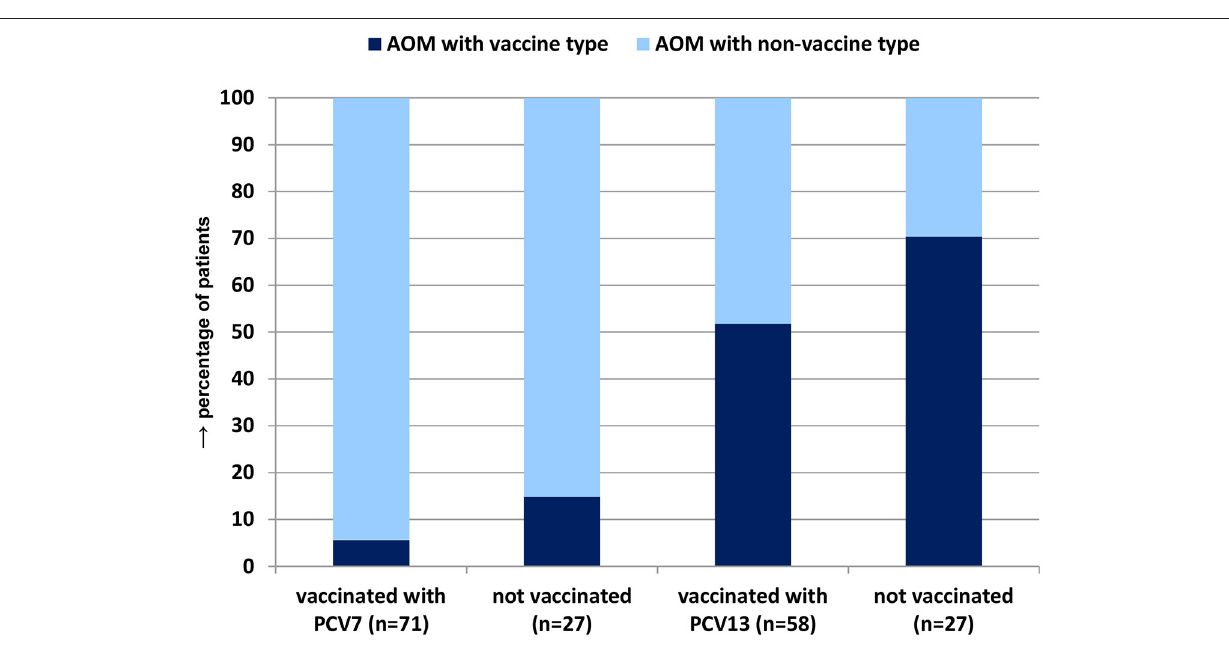
associated with carriage of S. pyogenes . M. catarrhalis AOM